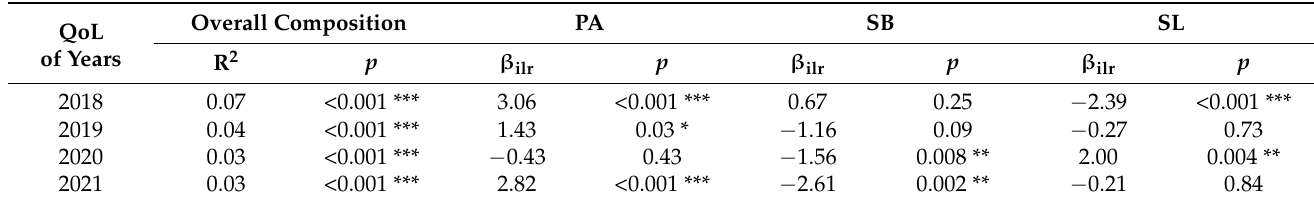
Table 3. Adjusted linear regression models for QoL of preschoolers with PA, SB, and SL.